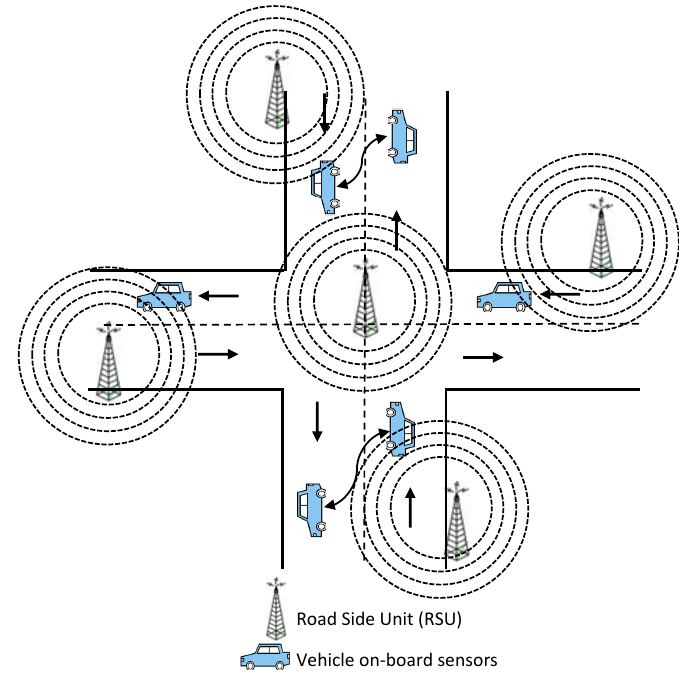
Figure 1. Internet of Vehicles (IoV) road network